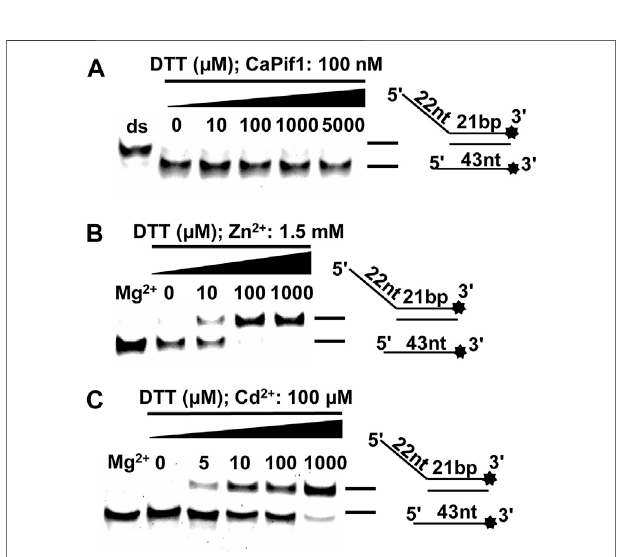
FIGURE 7 | The effects of DTT on CaPif1 unwinding activity inhibited by Zn 2+ andCd 2+ . (A) TheunwindingactivityofCaPif1atdifferentconcentrations of DTT, containing only MgCl 2 , no other divalent metal ions. (B – C) The unwinding activity of CaPif1 at 1.5 mM Zn 2+ or 100 μ M Cd 2+ and differentconcentrationsofDTT.LaneMg 2+ :Astandardunwindingexperiment containing MgCl 2 without Zn 2+ or Cd 2+